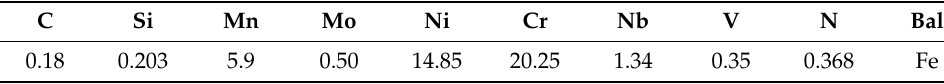
Table 1. The chemical composition of the experimental steel (mass, %).